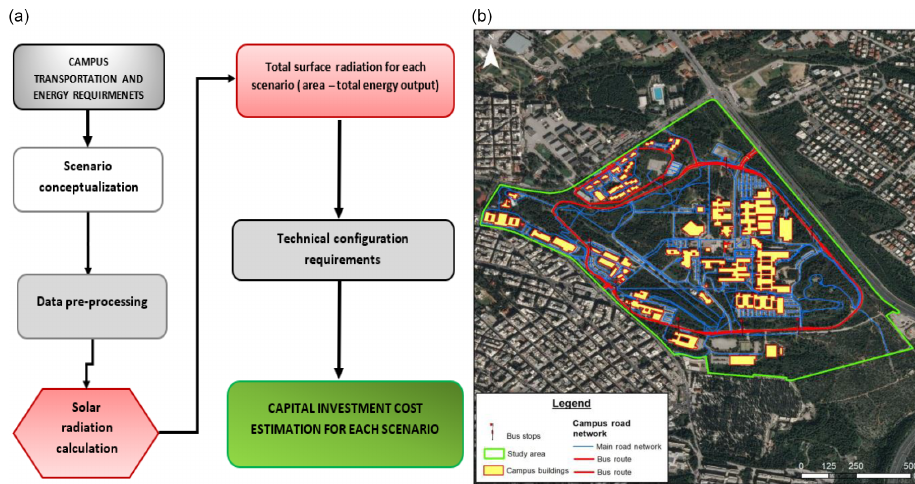
Figure 1. (a) Flowchart of the methodology. (b) Vectorized data of the study area (road network, bus stops, buildings, boundaries – Base Map Layer: Bing Map v.7, Bing Satellite Base Map).